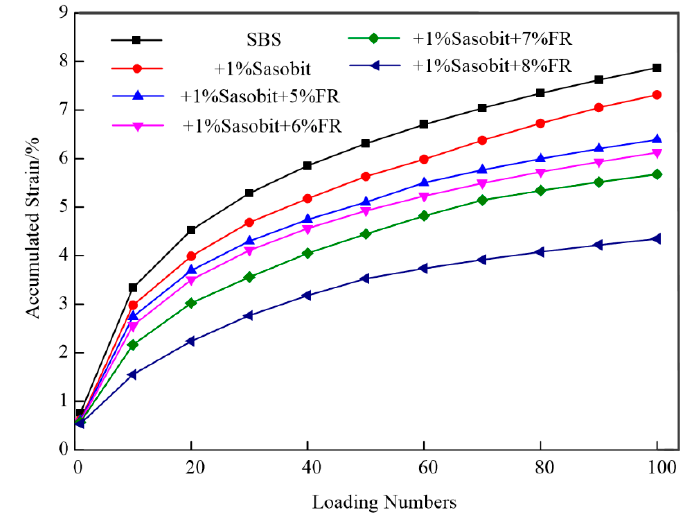
Figure 11. The relationship between loading numbers and cumulative strain at 50 °C.